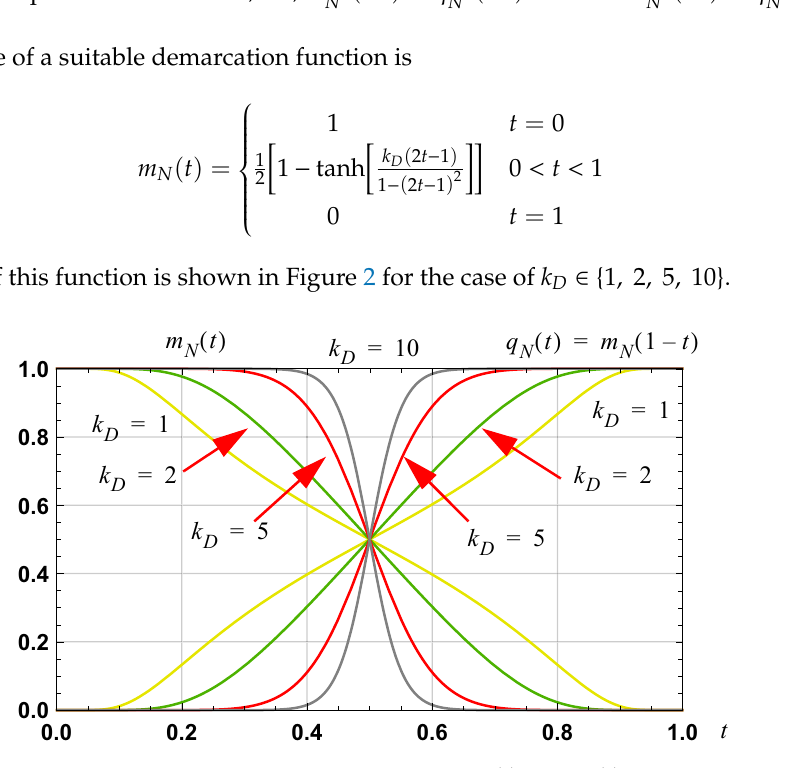
Figure 1. Illustration of the normalized demarcation functions and